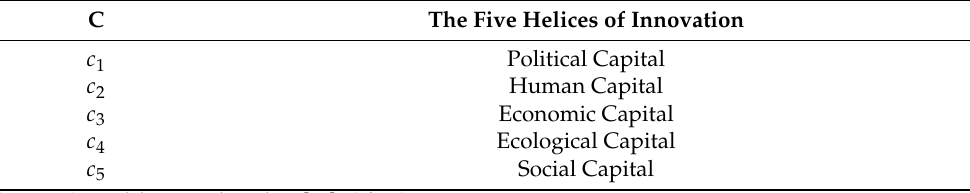
Table 1. The five helices of